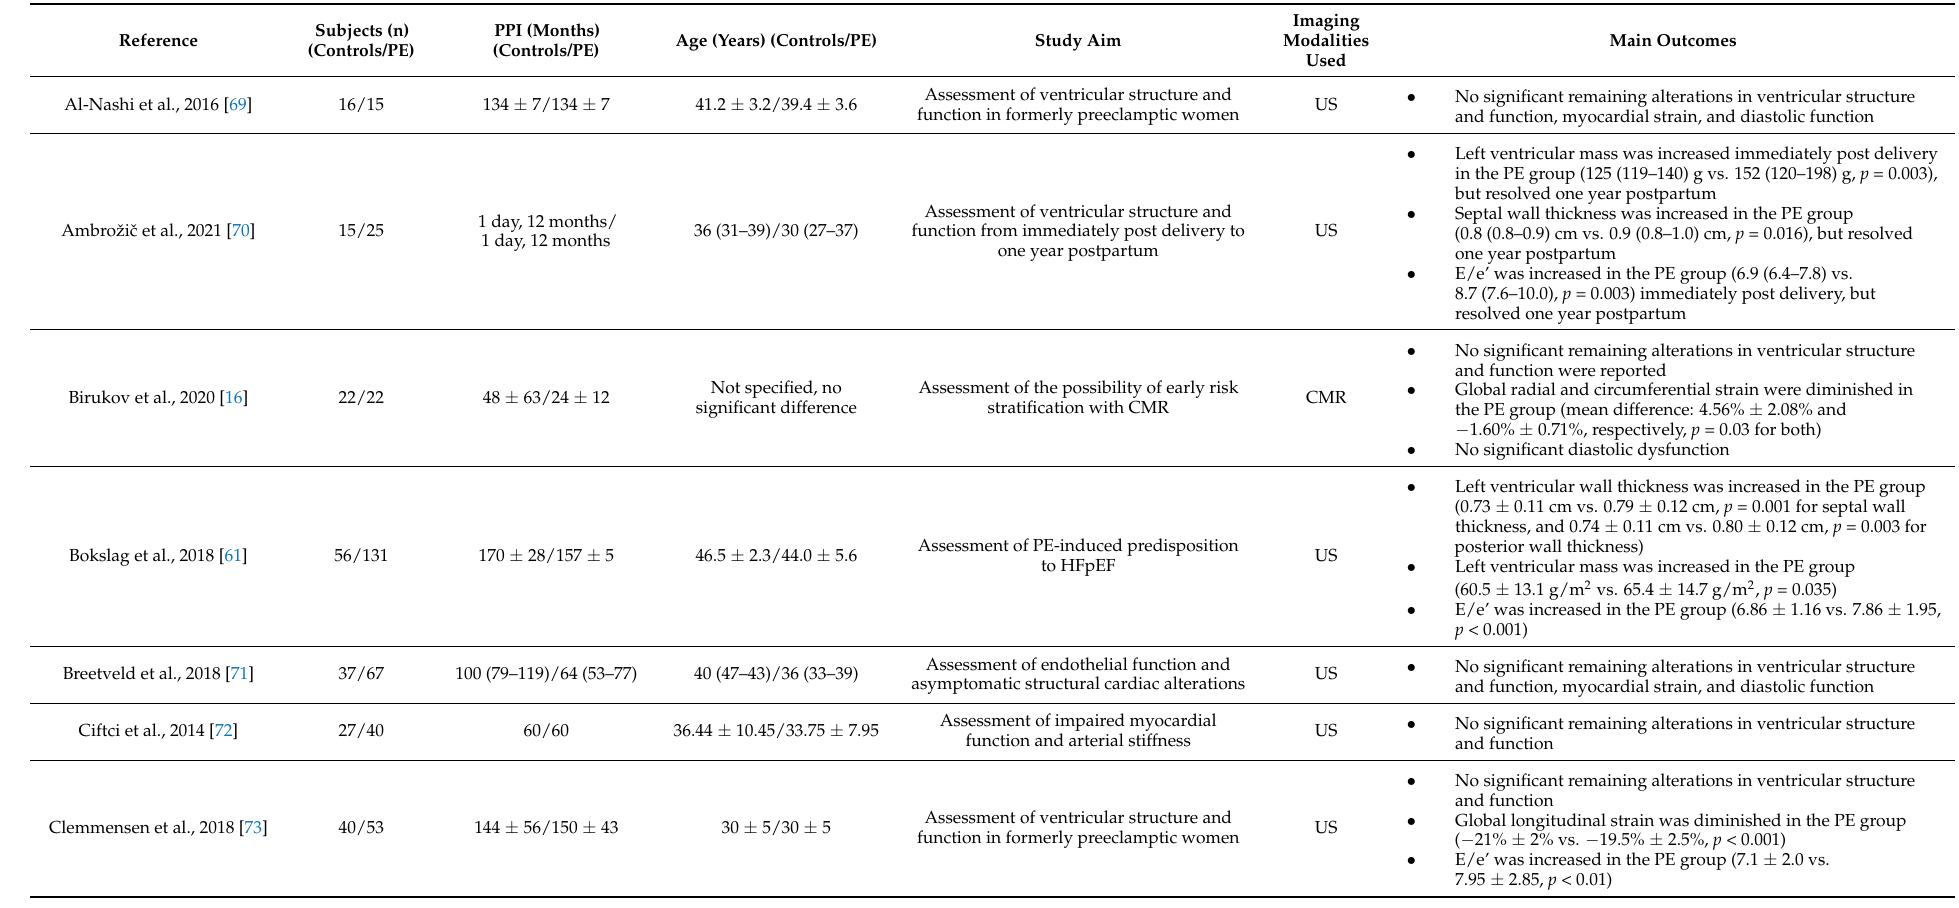
Table 2. Research findings of the in-depth literature study. PPI = postpartum interval in months (unless specified otherwise), US = ultrasound, CMR = cardiac magnetic resonance imaging, PE =